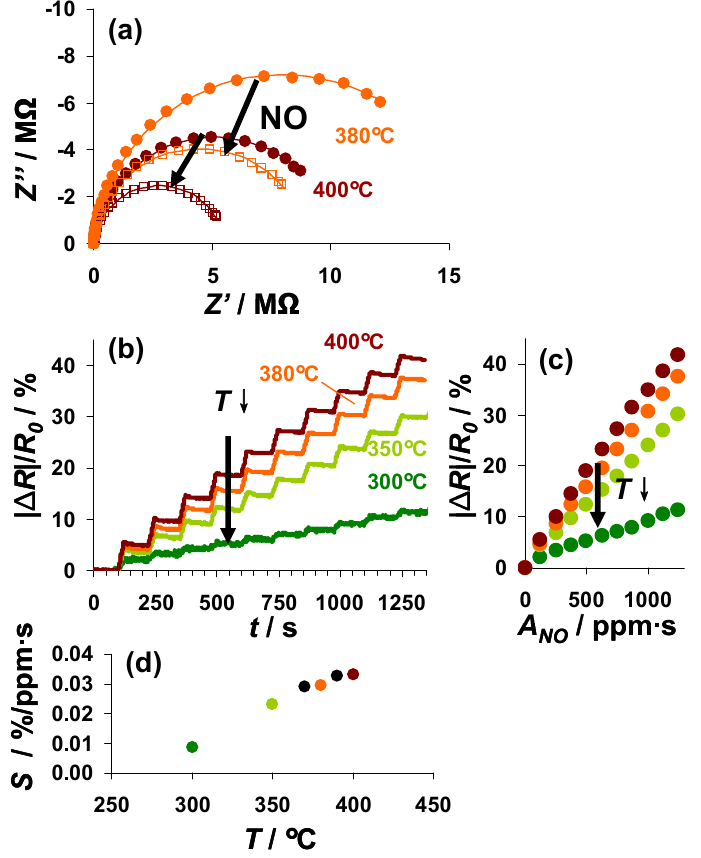
Figure 8. Influence of the temperature on the sensor response to 10 times 5 ppm NO for 25